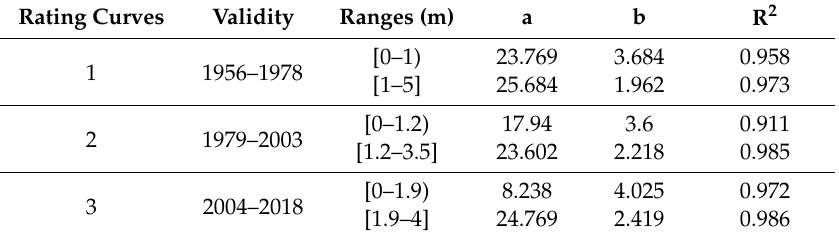
Table 3. Coefficients of the ANADIA rating curves equations of the Garbey Kourou gauging station. Rating curves